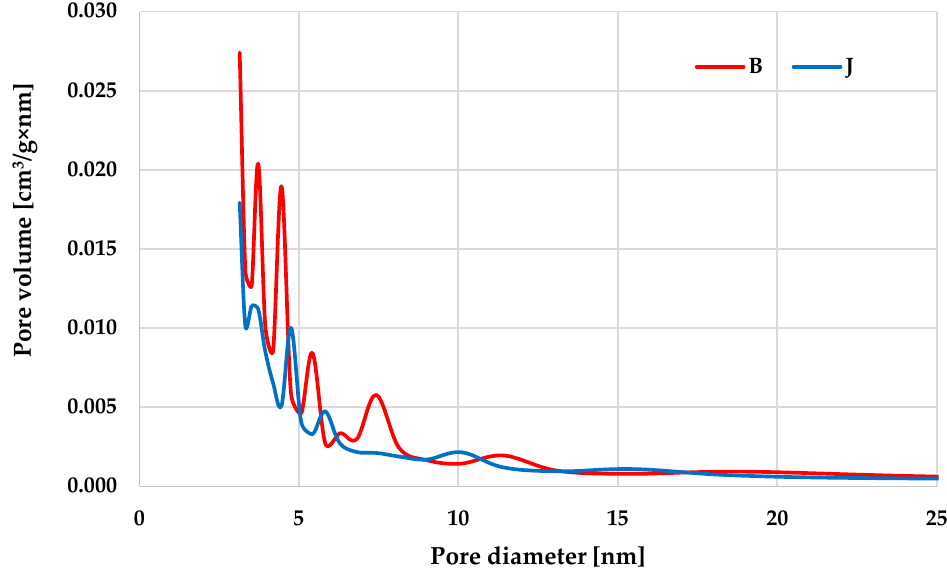
Figure 4. Pore size distribution of carbonaceous materials recovered from exhausted filter car- tridges.